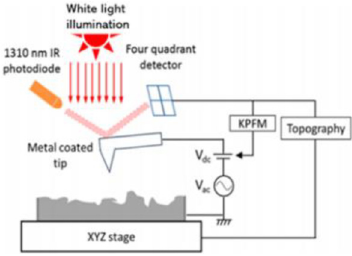
Fig. 2. Schematic diagram of KPFM system used in this analysis. While an AC +DC potential is applied, the KPFM tip scans across a surface. The AC signal is sinusoidal with a frequency that equals the mechanical resonance of the cantilever. The four-quadrant detector gives feedback in order to minimize cantilever oscillation modifying the DC signal providing the sample surface potential relative to that of the